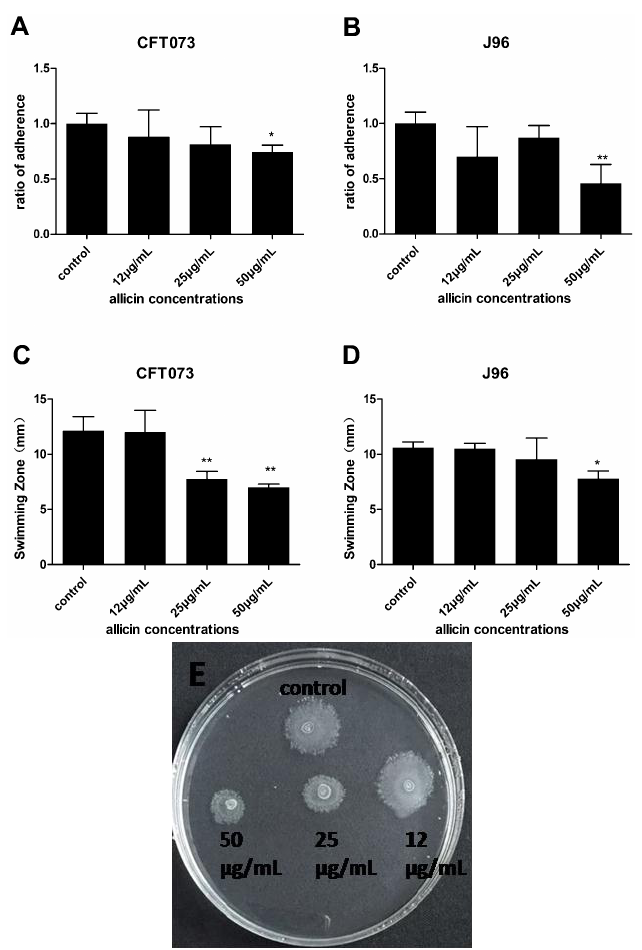
Figure 5. Effect of allicin on UPEC adhesion ability ( A , B ) and swimming motility ( C , D ). Ratio of adherence = Adherent bacteria of allicin treatment/Adherent bacteria of control. * and ** show statistically significant differences in values ( p < 0.05 and p < 0.01, respectively) compared to the control. Representative image of UPEC CFT073 swimming zone in the absence and presence of allicin was presented ( E ).